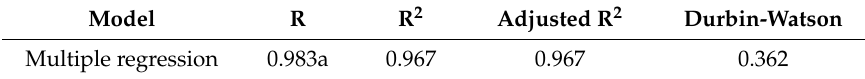
Table 12. Model summary.